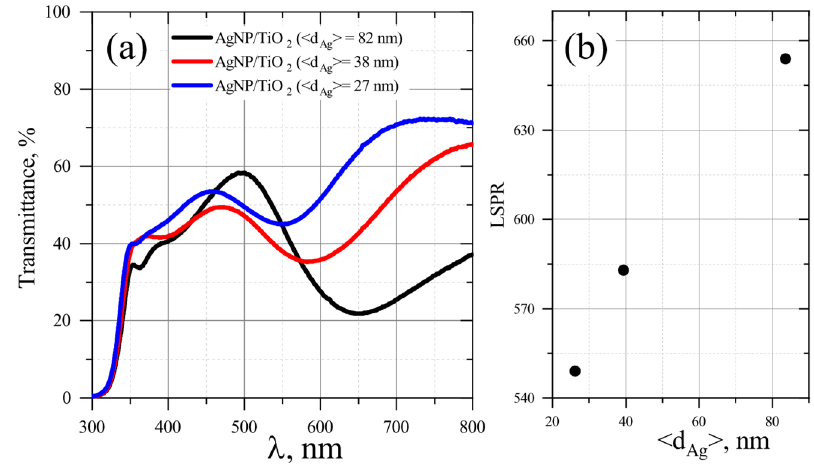
Figure 5. ( a ) Transmittance spectra of AgNP/TiO 2 structures and ( b ) LSPR dependency on < d Ag >.